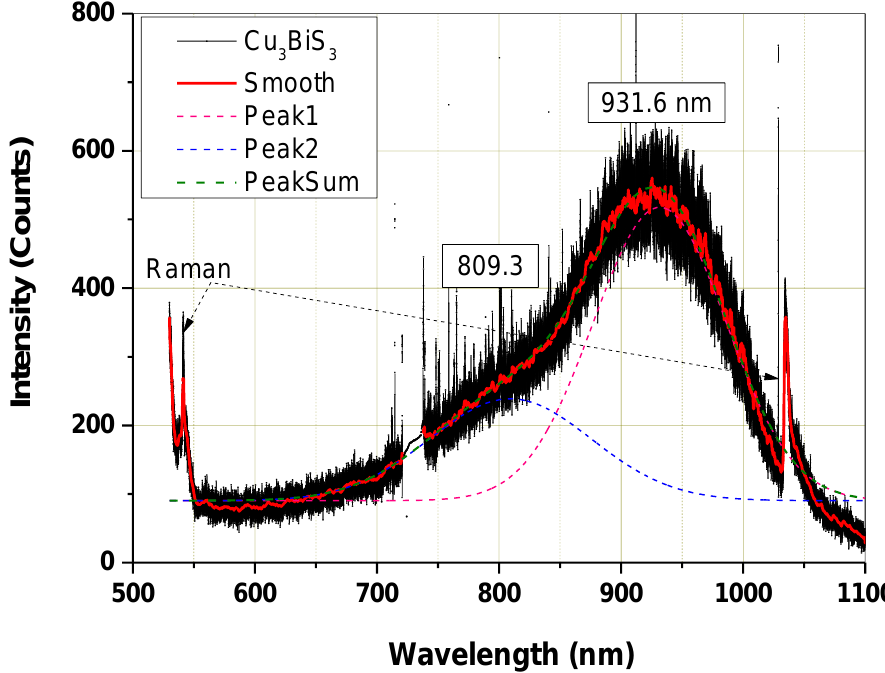
Figure 7. Wavelength-dependent micro-PL spectrum of mechanochemically synthesized Cu 3 BiS 3 after 5 min of milling measured upon excitation of the sample with a wavelength of 514 nm.